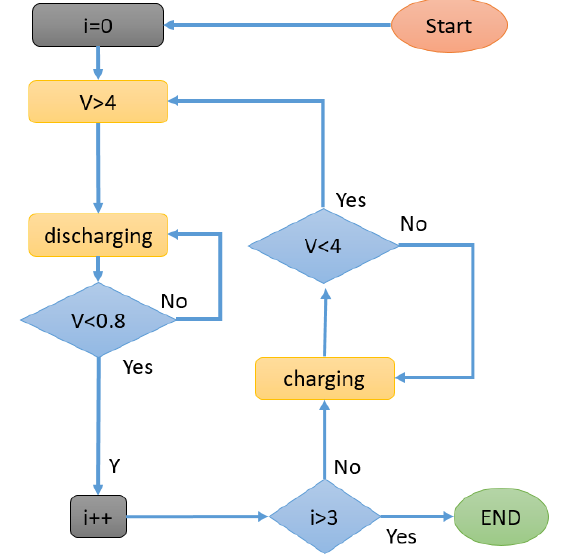
Figure 4. Methodology applied in the OD experiments.